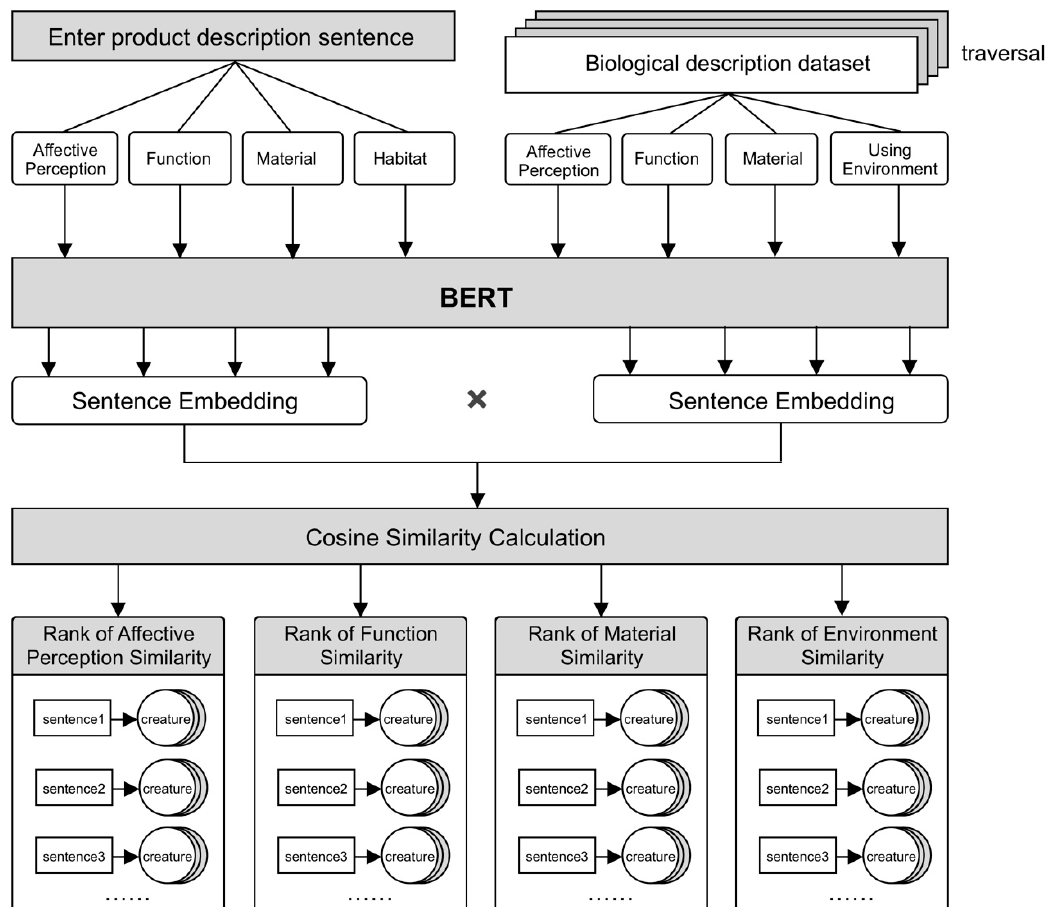
Figure 4. Semantic reasoning process from product to biology.